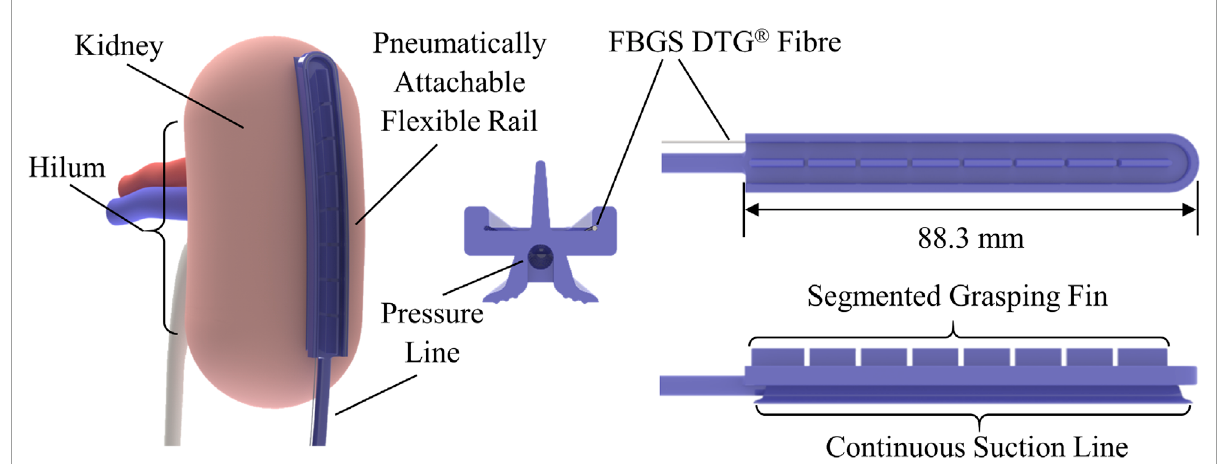
FIGURE 1 Schematic diagram of the PAF rail with integrated shape sensing fibre. The image on the left illustrates how the system could be attached to the kidney during RAPN. The images on the right illustrate the system design and the integration of the fibre sensing capability within the rail.